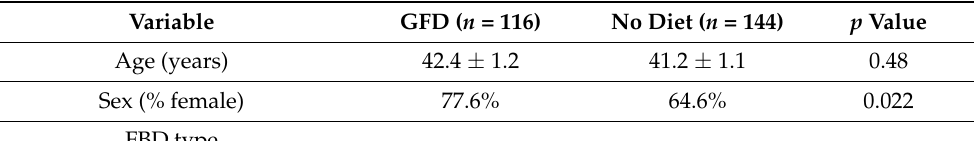
Table A1. Comparison of study variables between patients with functional bowel disease on or not on a